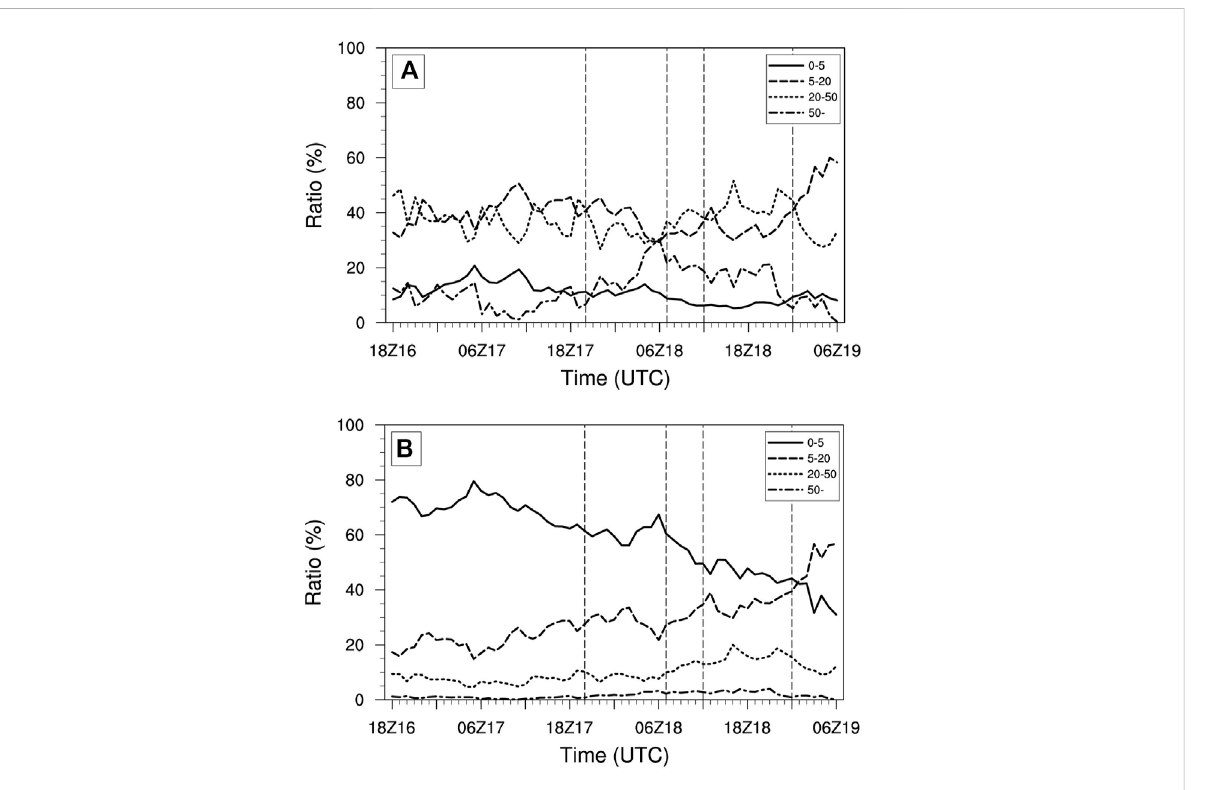
FIGURE 4 It is similar to Figure 3, but for the percentage (unit: %) of the rainfall (A) and numbers of grid points (B) of different hourly rainfall intensities to total rainfall and numbers of grid points in the gale circle